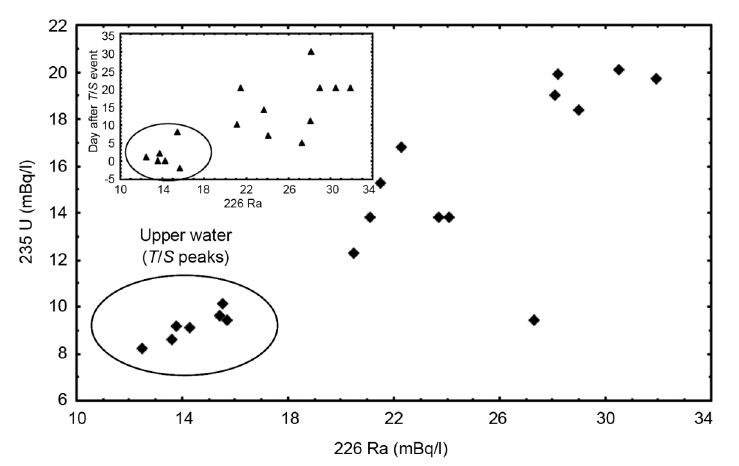
Fig. 7. 235 U versus 226 Ra. A group of lower activity is distinguished, referring to samples closer to T / S peaks, in perfect analogy with fig. 5. The smaller plot shows the clustering in relation to the temporal distance (in days) of water sampling after a T / S